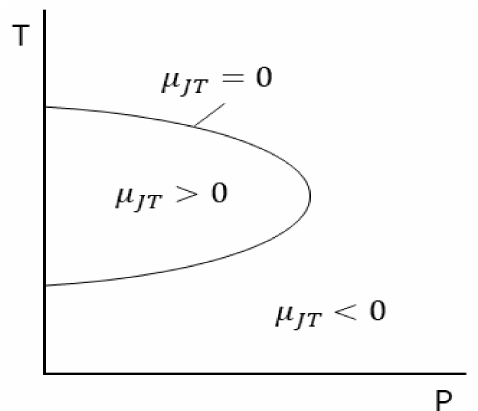
Figure 6. Joule–Thomson